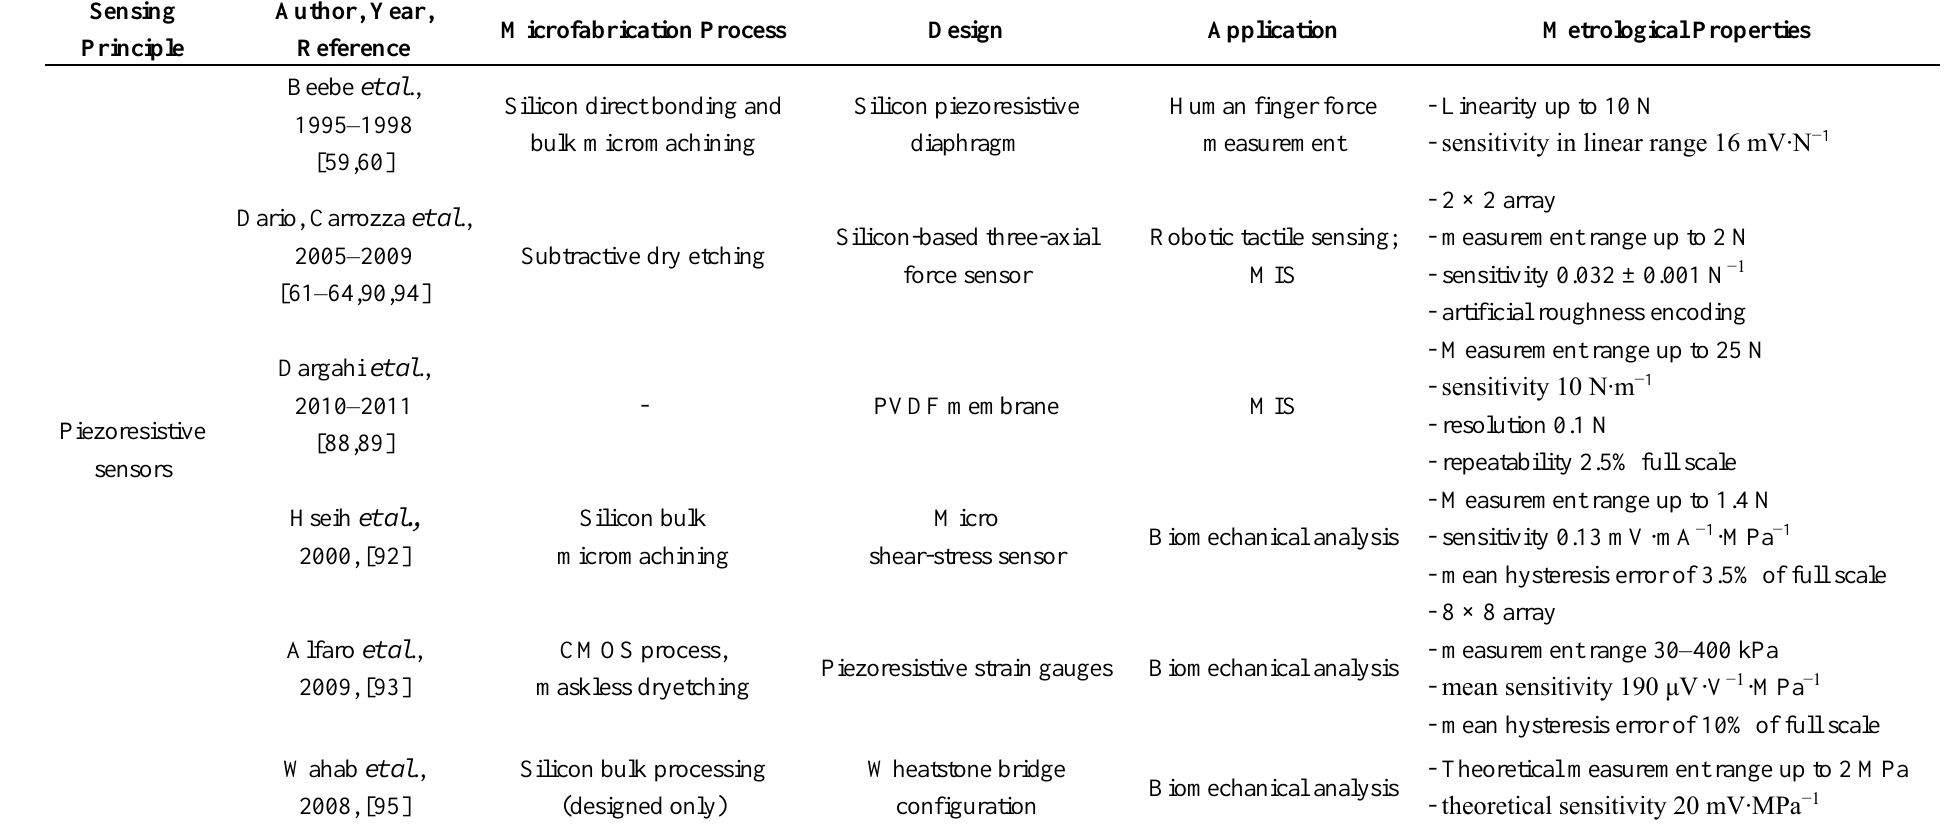
Table 1. Sensing principle, microfabrication process, design, applications and metrological properties of tactile